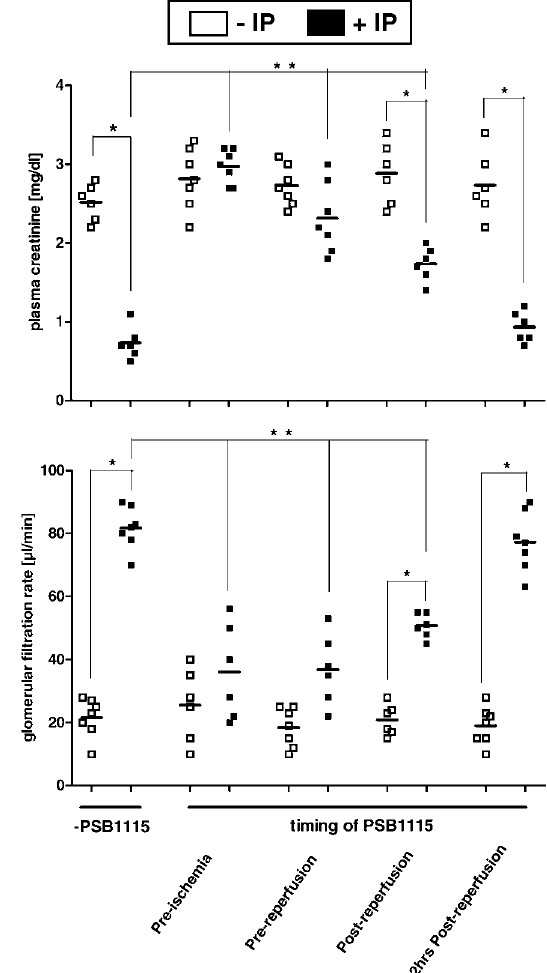
Figure 7. Pharmacological Studies of A2BAR Signaling during Renal Ischemia and Preconditioning A2BAR antagonist (PSB1115): Age-, weight-, and gender-matched C57BL/ 6J underwent right nephrectomy. Prior to the surgery, immediately before ischemia, 5 min or 2 h after ischemia, they received the selective A2BAR antagonist PSB1115 (5 mg/kg, intravenous) or treatment with a vehicle control. They were exposed to 45 min of left renal artery ischemia with or without prior in situ IP (consisting of four cycles of 4 min ischemia followed by 4 min of reperfusion). (A) Plasma creatinine and (B) GFR as assessed by inulin clearance were obtained after 24 h of reperfusion. Statistics: One-way ANOVA with Tukey’s post-hoc test was performed (*, p , 0.001 versus the respective group without IP; **, p , 0.001 versus WT mice with IP and with PSB115 treatment). The F -test results are (A) F (9,54) ¼ 42.20, p , 0.001; (B) F (9,55) ¼ 51.67, p ,